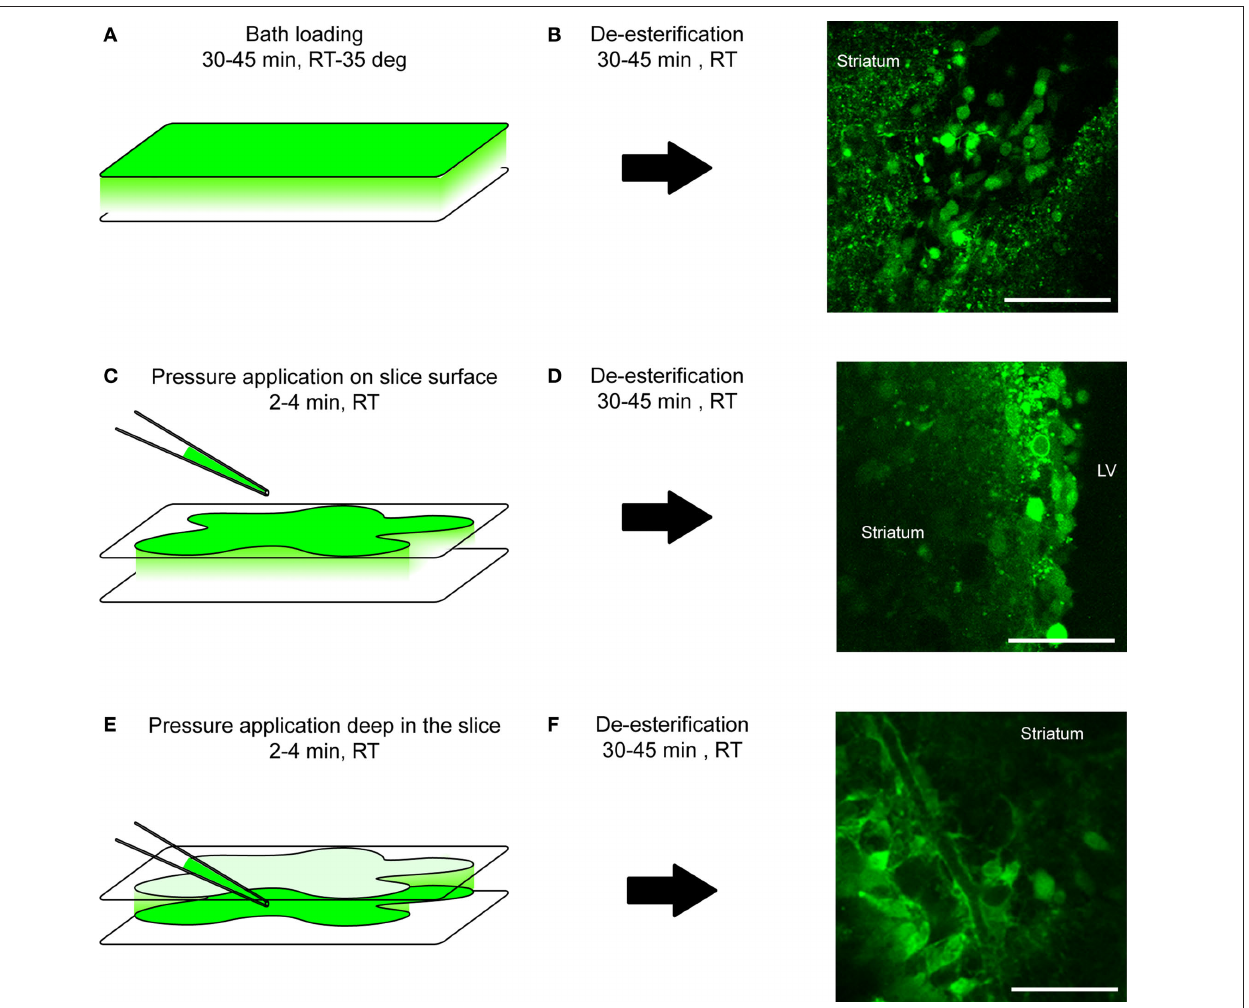
Figure 5 | Loading protocol of calcium indicator dyes. (A, C, e) Diagram illustrating the loading protocol of a calcium indicator dye: by bath also called bulk loading (A) , by pressure application on top of the tissue (C) or inside the tissue (e) . RT, room temperature; deg, degree. (B, D, F) After a 30- to 45-min de-esterification time-period at room temperature (RT), loading cells progressively become fluorescent upon proper excitation as shown on confocal images on the right. Scale bar: 50 μm (B, D, F)